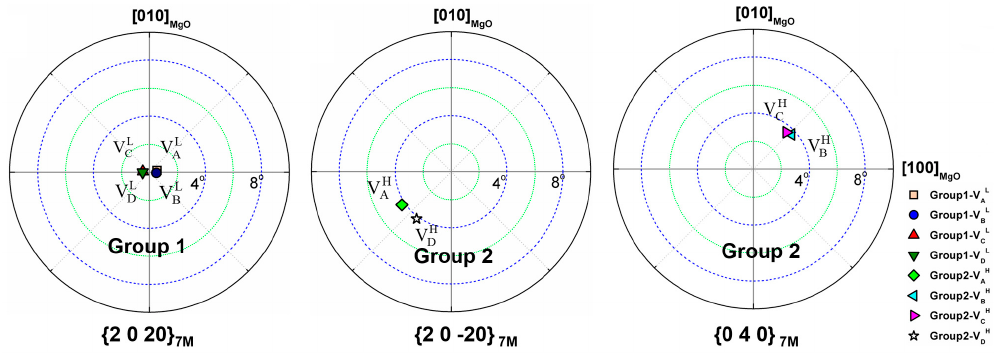
Figure 14. {2 0 20} 7M , {2 0 − 20} 7M and {0 4 0} 7M pole figures of four 7M variants in Group 1 and Group 2.